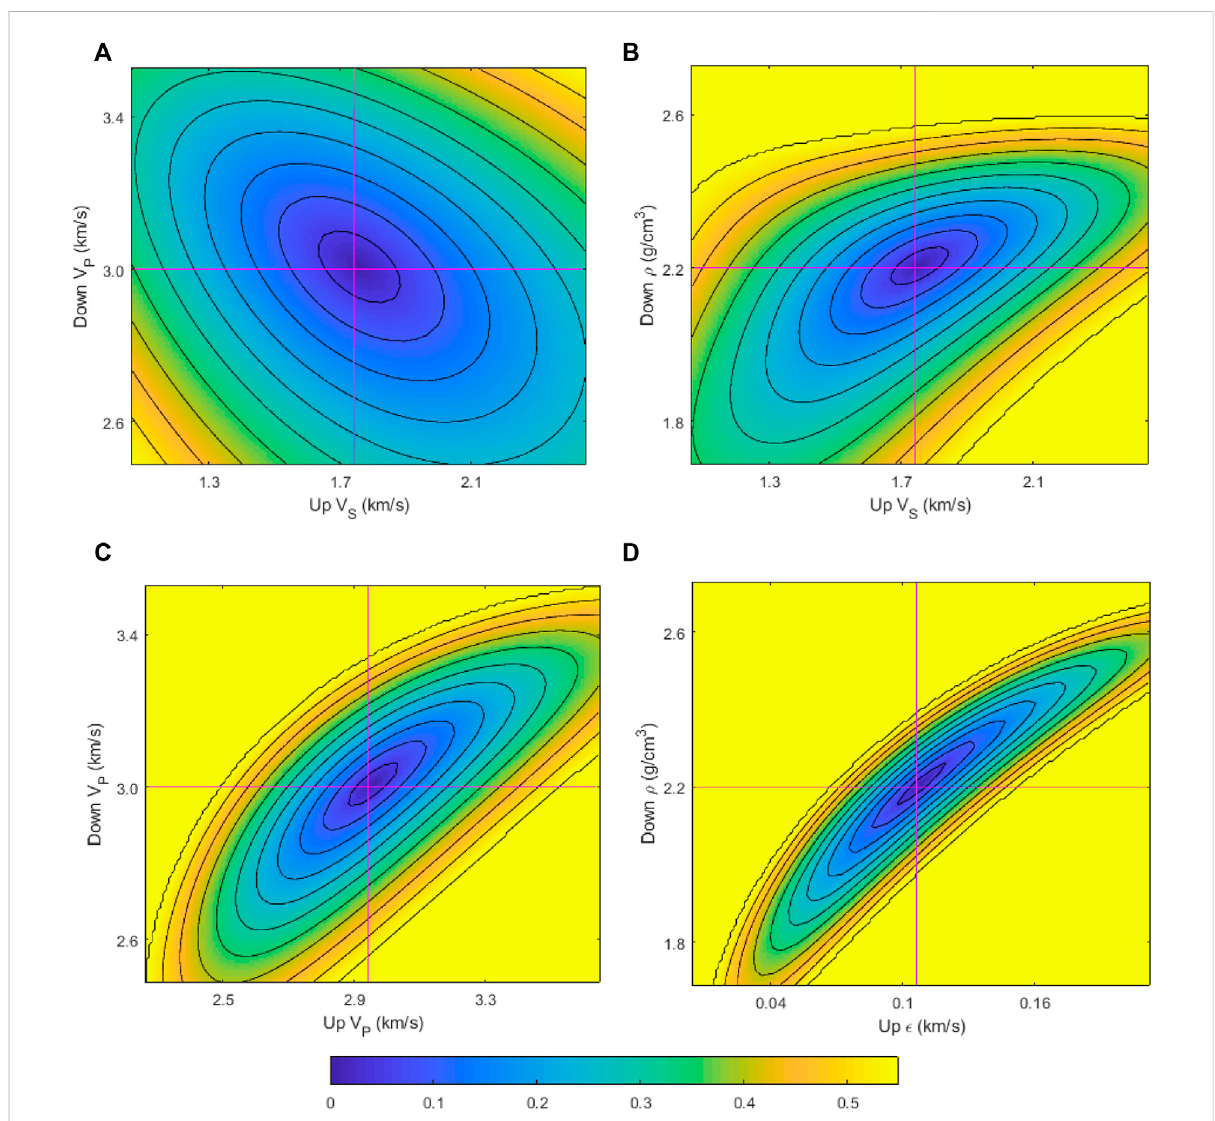
FIGURE 2 Residual function maps. The adjacent contour increment is 0.08. The intersection of the red line represents the corresponding real value. The colorbar at the bottom indicates the corresponding numerical value of each